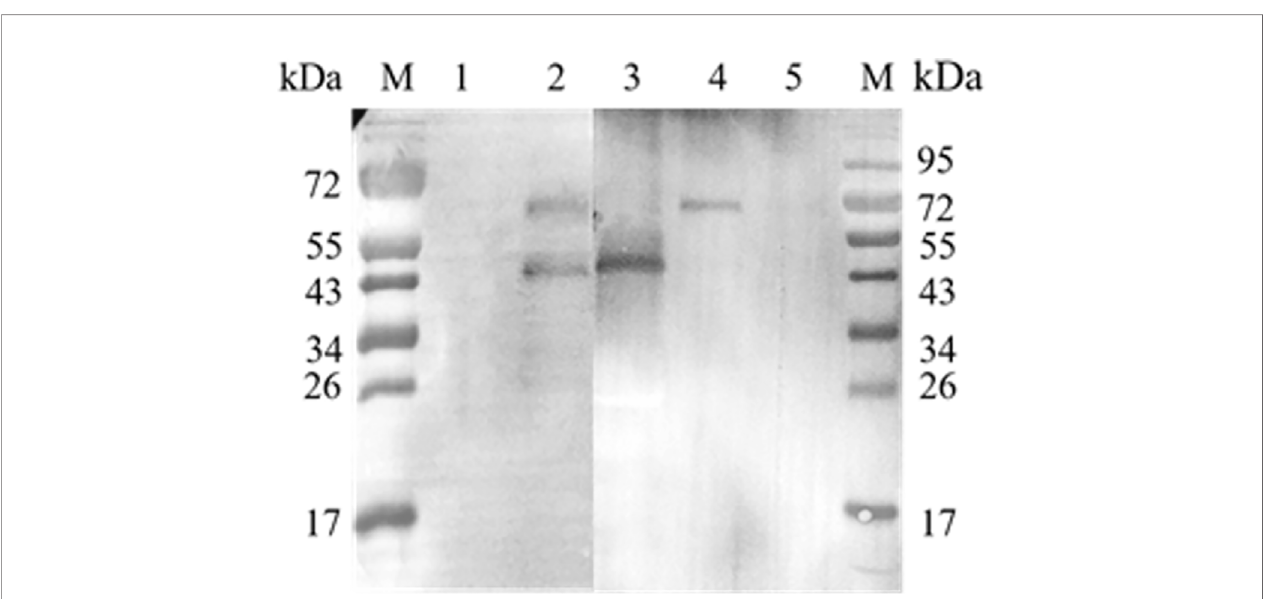
FIGURE 5 | Co-immunoprecipitation of Et CDPK4 and Et eIF-5A. M, molecular weight marker; 1, negative control; 2, blot probed with anti-r Et eIF-5A and anti- r Et CDPK4 serum (Sample group); 3, puri fi ed protein of r Et eIF-5A; 4, puri fi ed protein of r Et CDPK4; 5, blank control with pre-immune rabbit